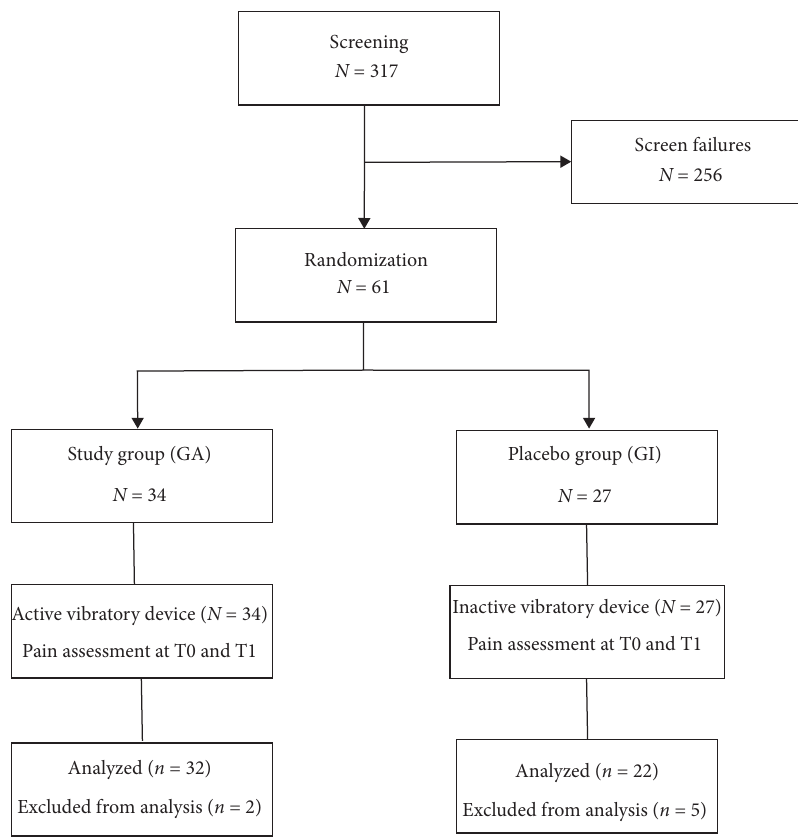
Figure 1: CONSORT flow diagram of patient enrollment and